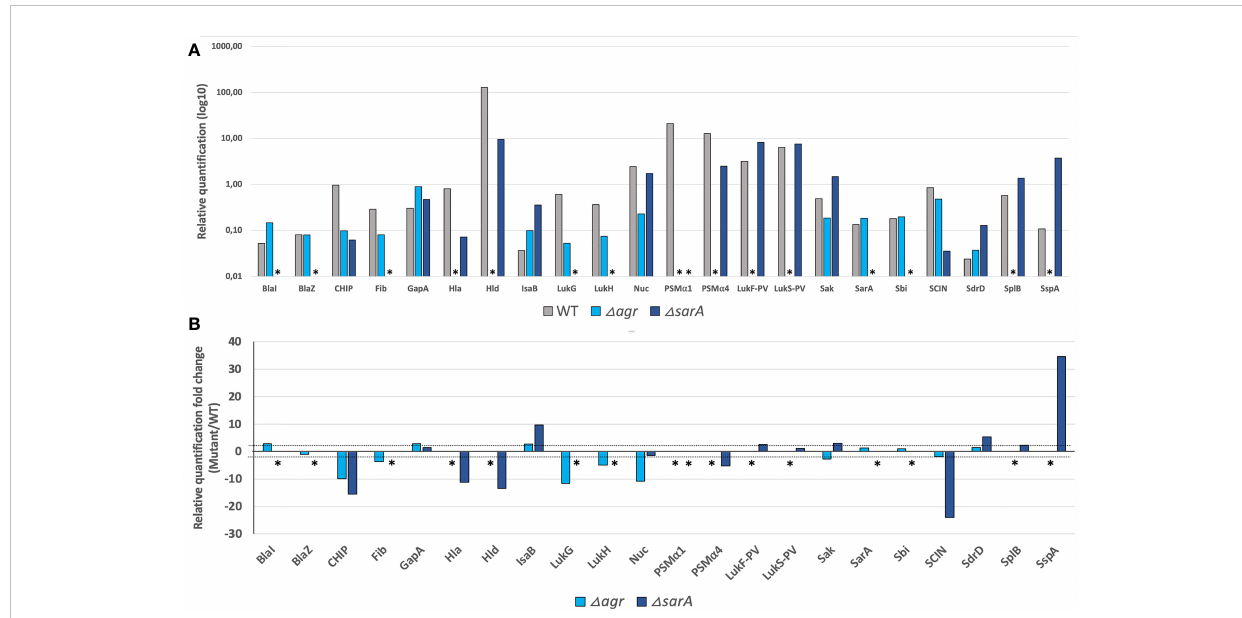
FIGURE 1 Deletions in major S. aureus regulators induced expected variations in proteomic pro fi les. Comparison of the proteomic pro fi les of USA300 WT (grey) and its mutants USA300 D agr (light blue) and USA300 D sarA (dark blue). (A) Relative amounts of the virulence factors most affected by the agr and/or sar A deletions, expressed in log10. * indicates the absence of protein detection. (B) Fold change of the relative quanti fi cation for the most affected virulence factors between USA300 WT and USA300 D agr or D sarA . The thresholds of 2 and -2 are represented by the dashed lines, and * indicates the absence of protein detection in mutant compared to USA300